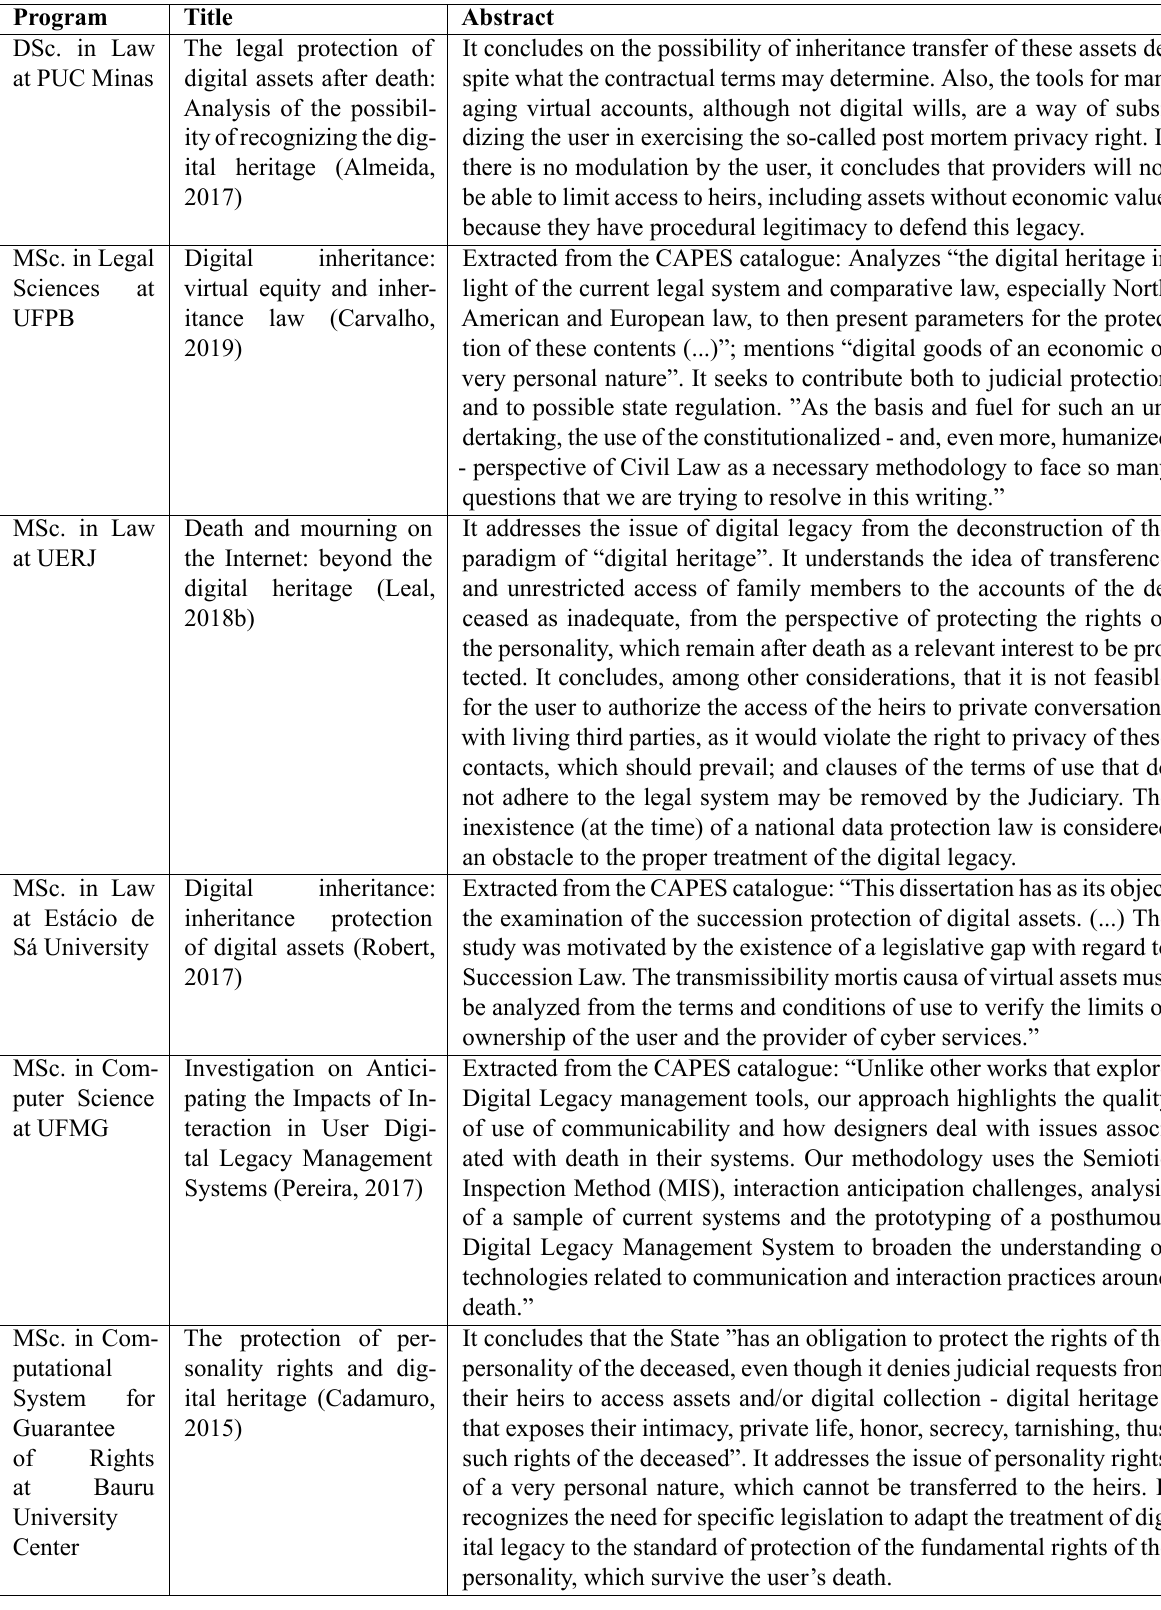
Table 1. Works discussing the treatment of the digital legacy from the perspective of personality rights in